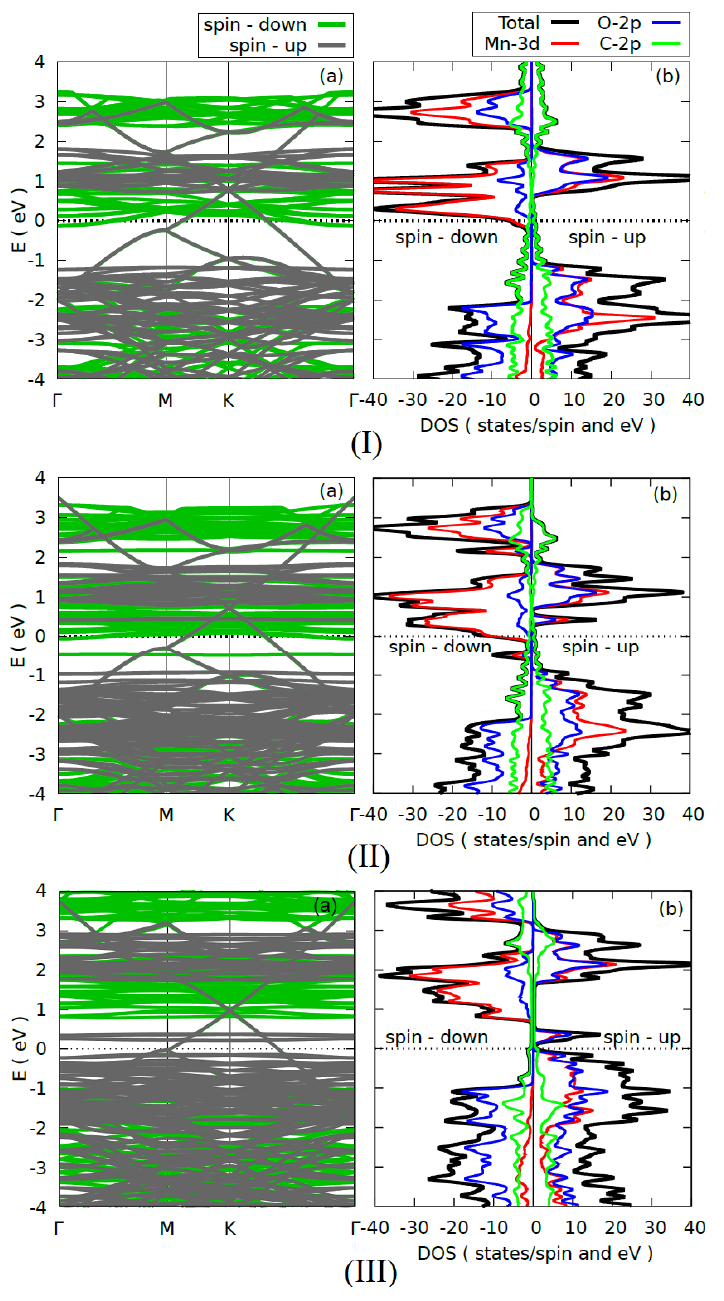
Figure 2. Electronic structure: ( a ) diagram of the energy bands and ( b ) DOS of the ( I ) T–MnO 2 /graphene without a vacancy, ( II ) T–MnO2/graphene with V O , and ( III ) T–MnO2/graphene with V Mn . The dotted line represents the Fermi level.